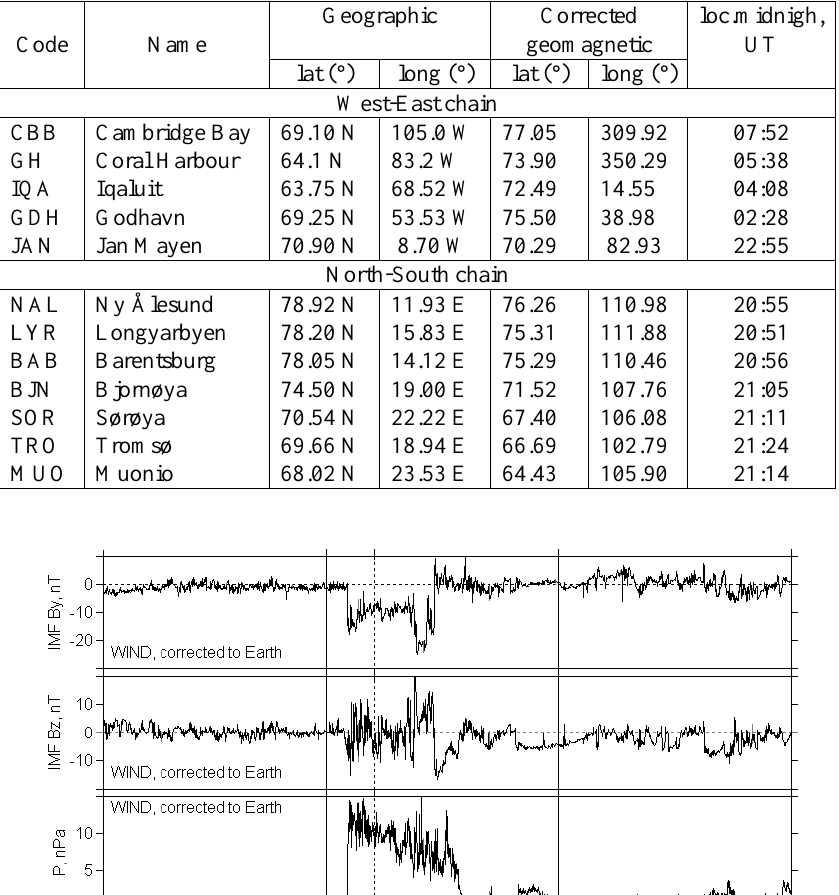
Table 1. List of observatories.